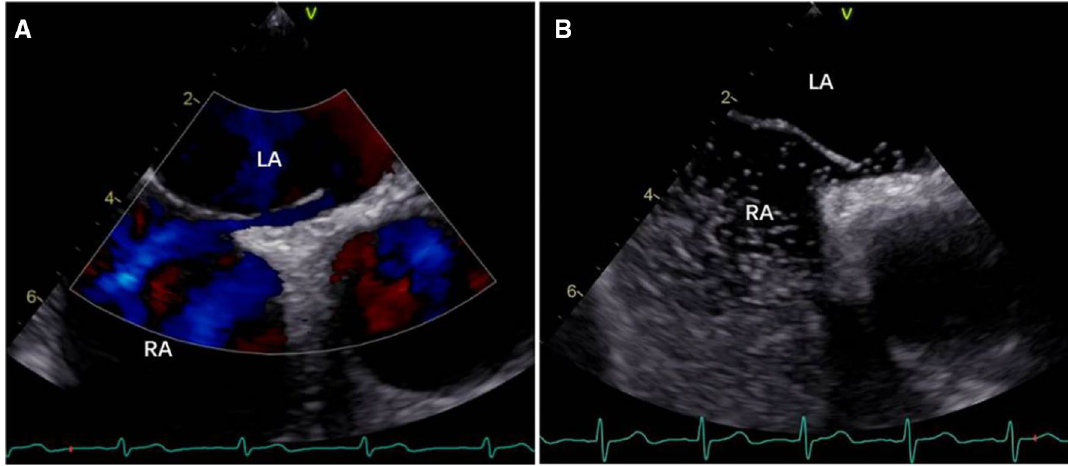
Fig. 1 PFO diagnosis. A Visualization of color Doppler flow through the atrial septum. B Microbubbles passing through the atrial septum; the number of microbubbles in the left atrium was